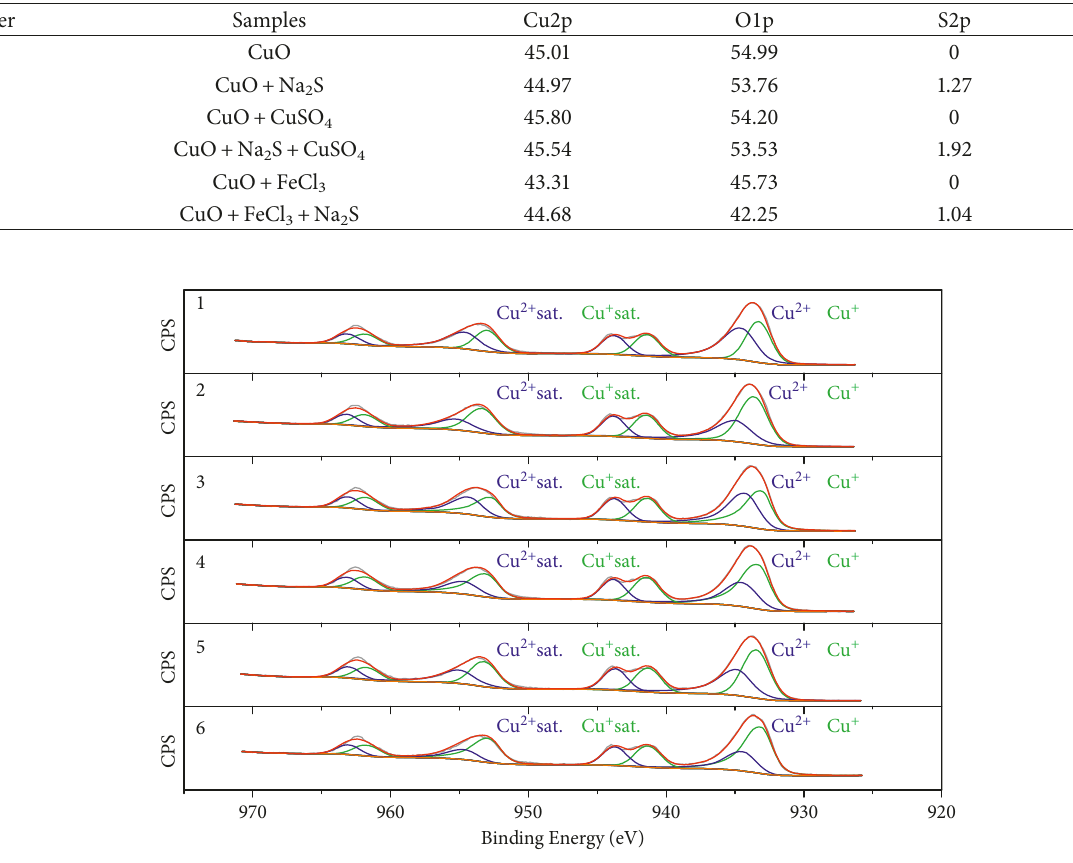
Figure 9: Cu2p spectra of CuO adsorption with and without different additions.